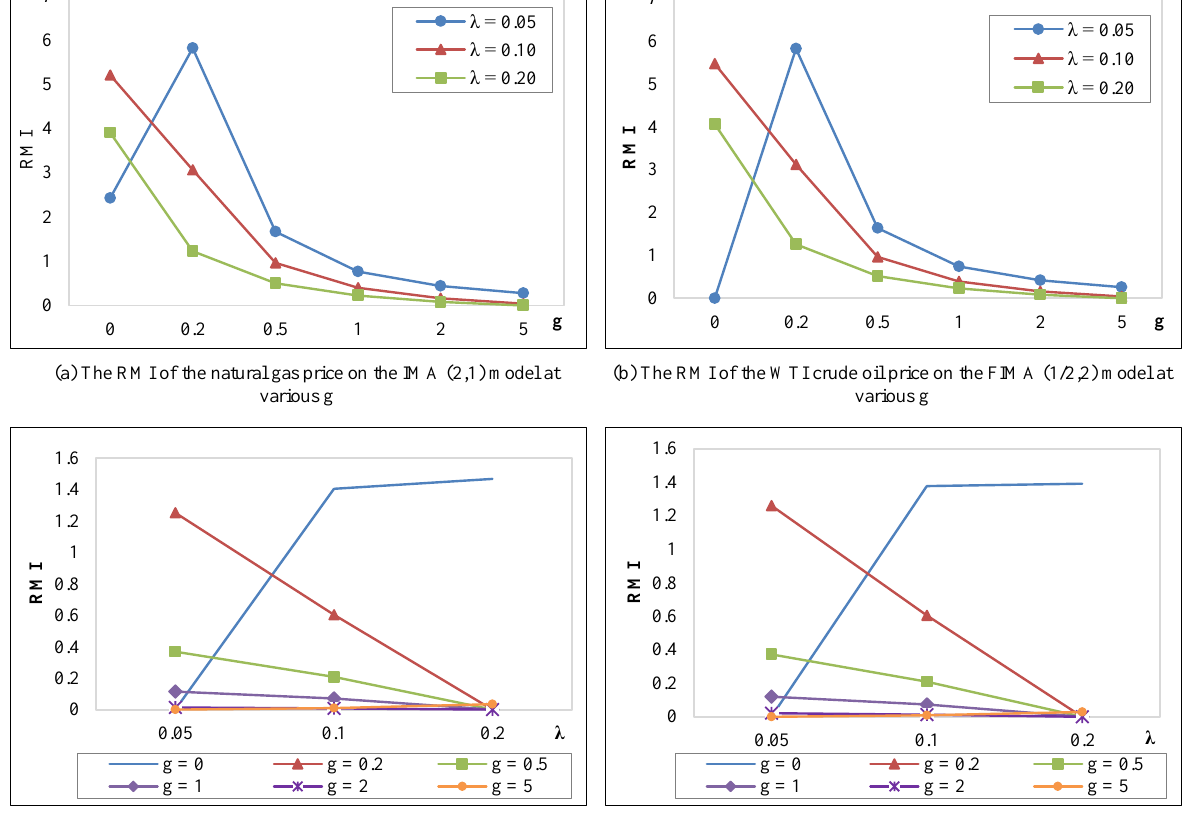
Figure 4. The RMI of two datasets at various